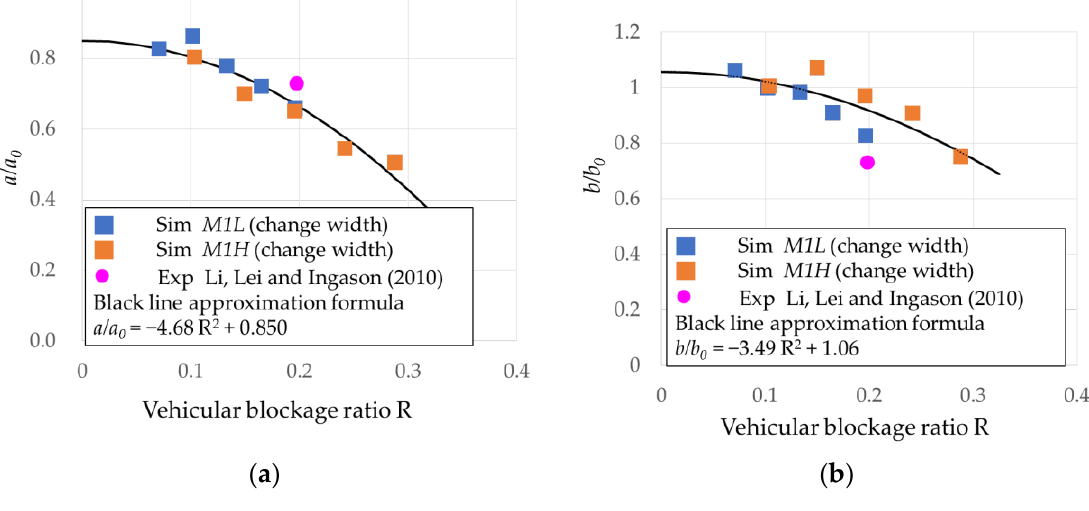
Figure 18. Approximation formula of Pattern B: ( a ) a / a 0 ; ( b ) b / b 0 .